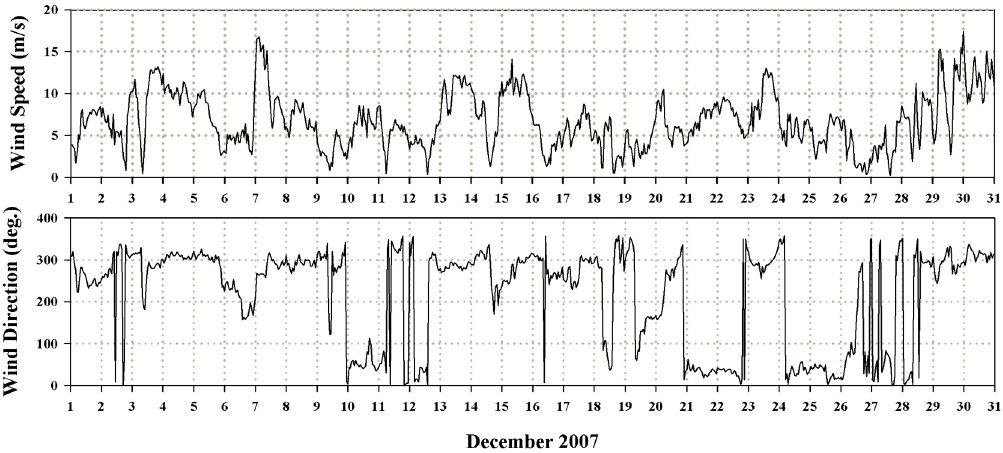
Figure 5. Time series of wind speed and direction observed in Gadaeam buoy.